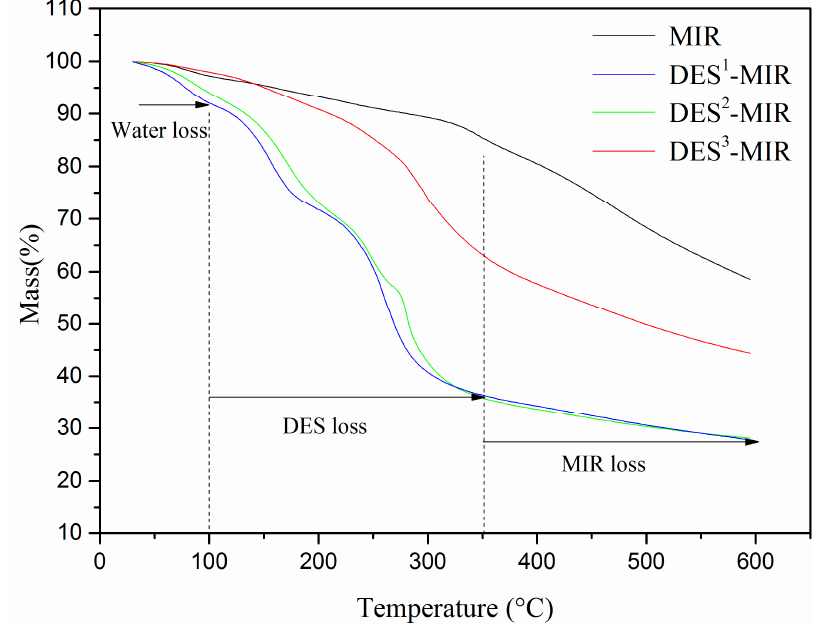
Figure 3. Thermogravimetric (TGA) curves of the MIR and DES-MIR (DES 1 -MIR, DES 2 -MIR and DES 3 -MIR).